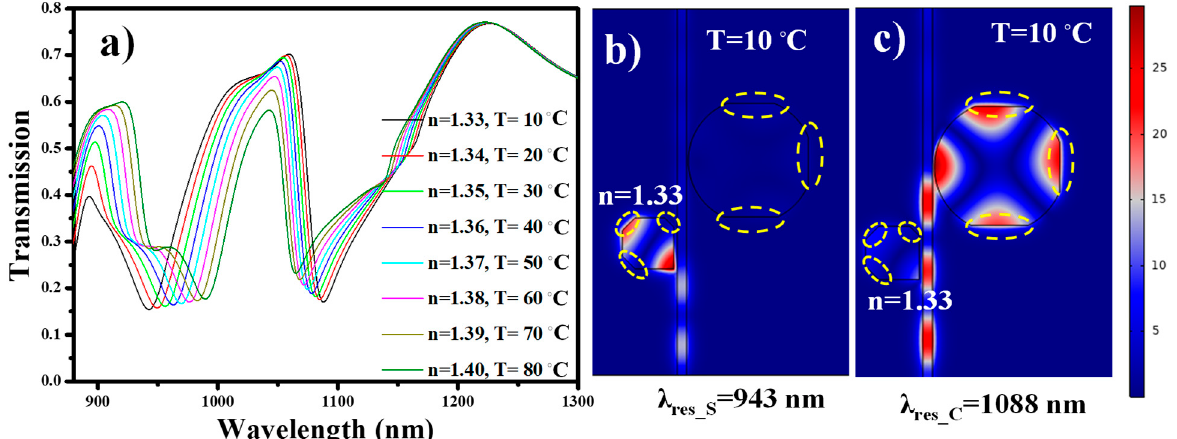
Figure 10. ( a ) Transmission spectrum of the over-etched device employed as biosensor and temperature sensor, ( b ) H-field distribution at λ res_S = 943 nm, and ( c ) H-field distribution at λ res_C = 1088 nm. The yellow dotted circle represents the fabrication inaccuracies.